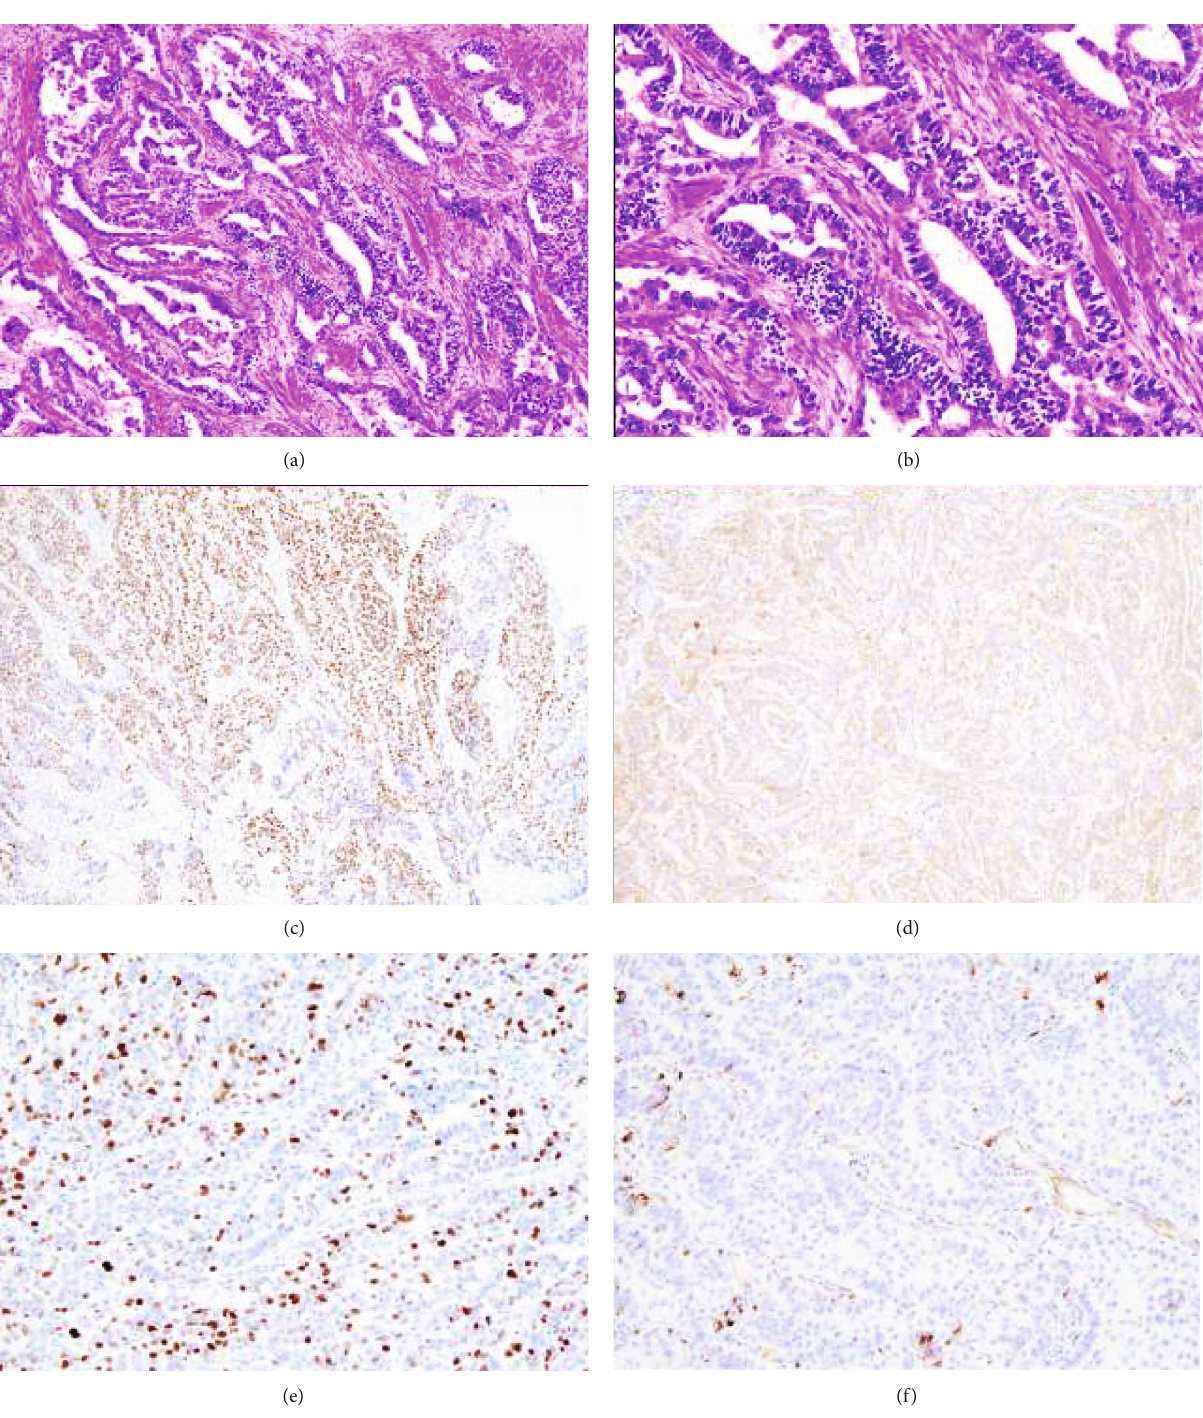
Figure 1: Histology image of the ordinary endometrioid carcinoma component. (a) Endometrioid glands were observed. (b) Higher magni fi cation of the endometrioid carcinoma component. (c) PAX8 was positive. (d) p16 immunostaining was patchy. (e) p53 was wild type. (f) WT-1 was negative. (A, B: H&E staining, A: × 10, B: × 20, Immunostaining C, D: × 10, E,F: ×